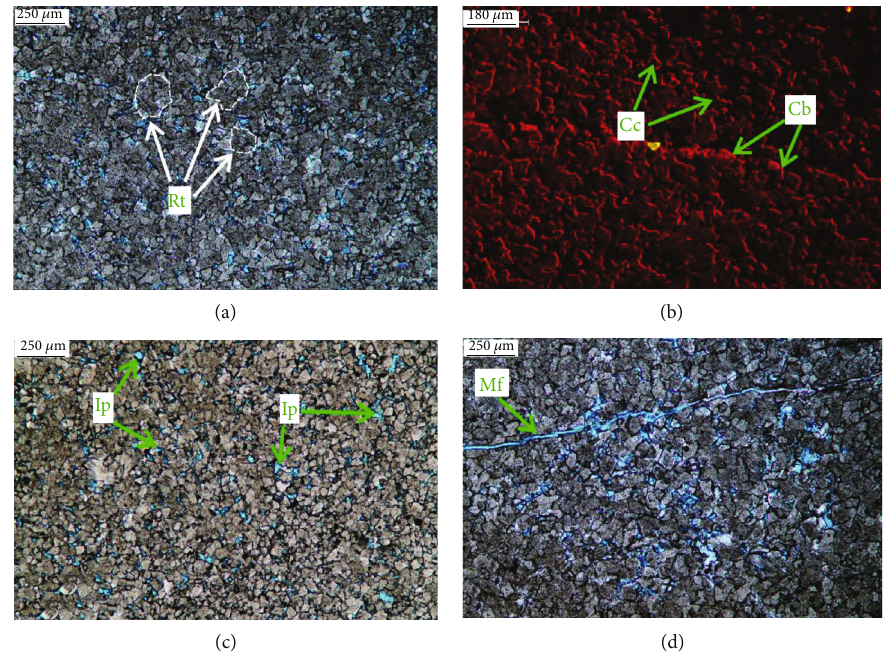
Figure 4: Microphotographs showing the petrographic characteristics of the Type-2 dolostone in submember Ma5 Ordos Basin (Rt=residual texture; Ip =intercrystalline pore; Cc =cloudy center; Cb =clear brim; and Mf =micro fracture). ((a). Residual texture of the primary limestone developed in the powder- fi ne crystalline dolostone, 3110.3m, well Y1758; (b). cloudy center and clear brim textures of the powder- fi ne crystalline dolostone, 3016.17m, well D48; (c). intercrystalline pores, 3110.0 m, well Y1758; (d). microfractures in powder- fi ne crystalline dolostone, 4040.5m, well